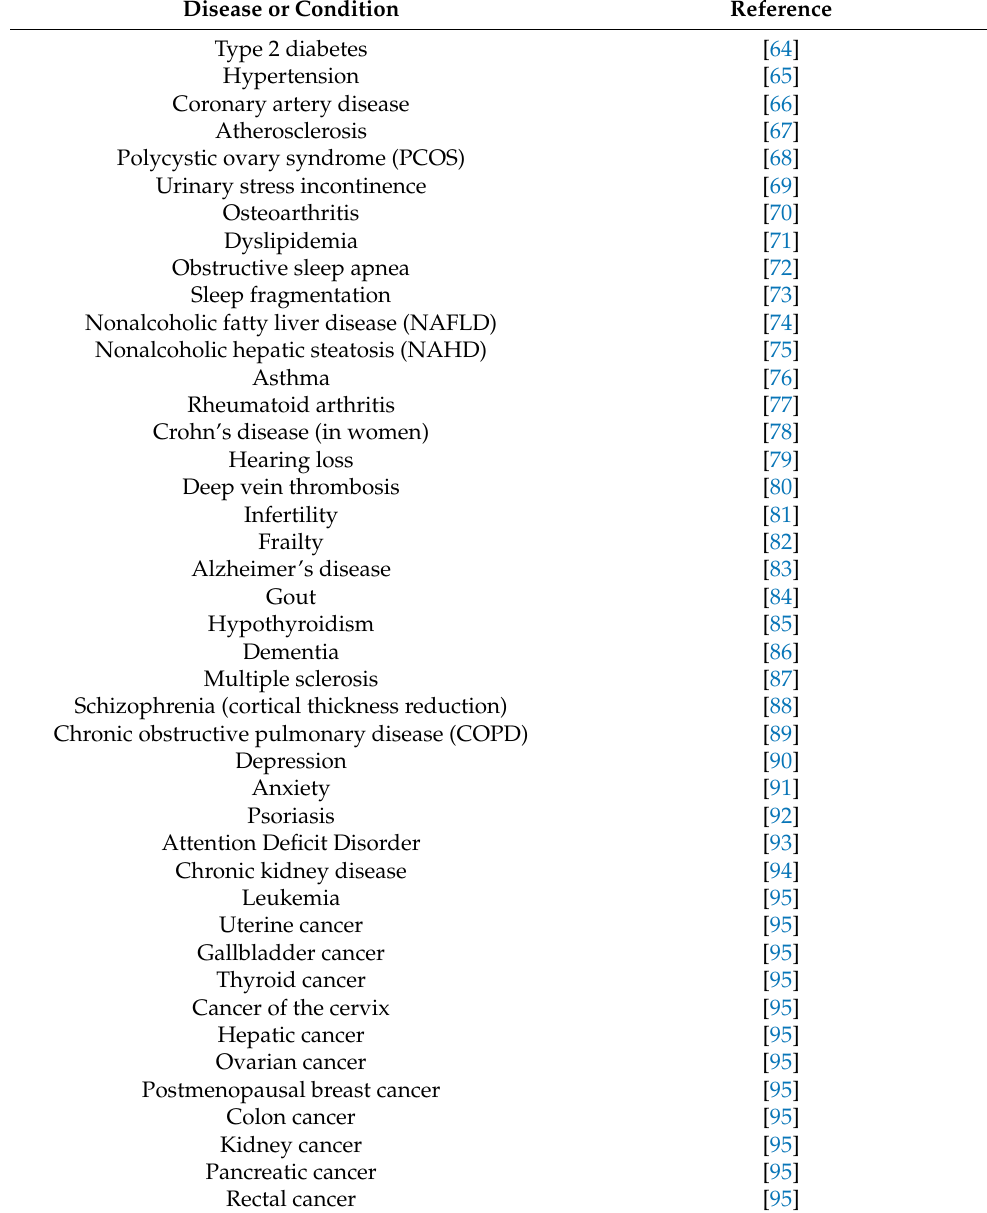
Table 2. Examples of Comorbidities of